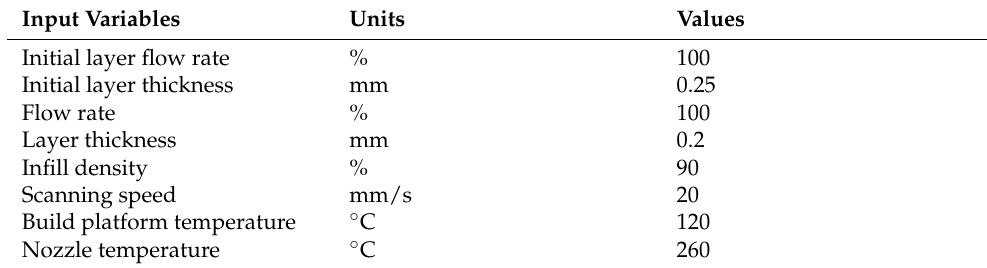
Table 2. Process parameters of the FDM process.